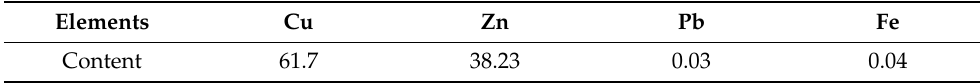
Table 2. Chemical compositions of H62